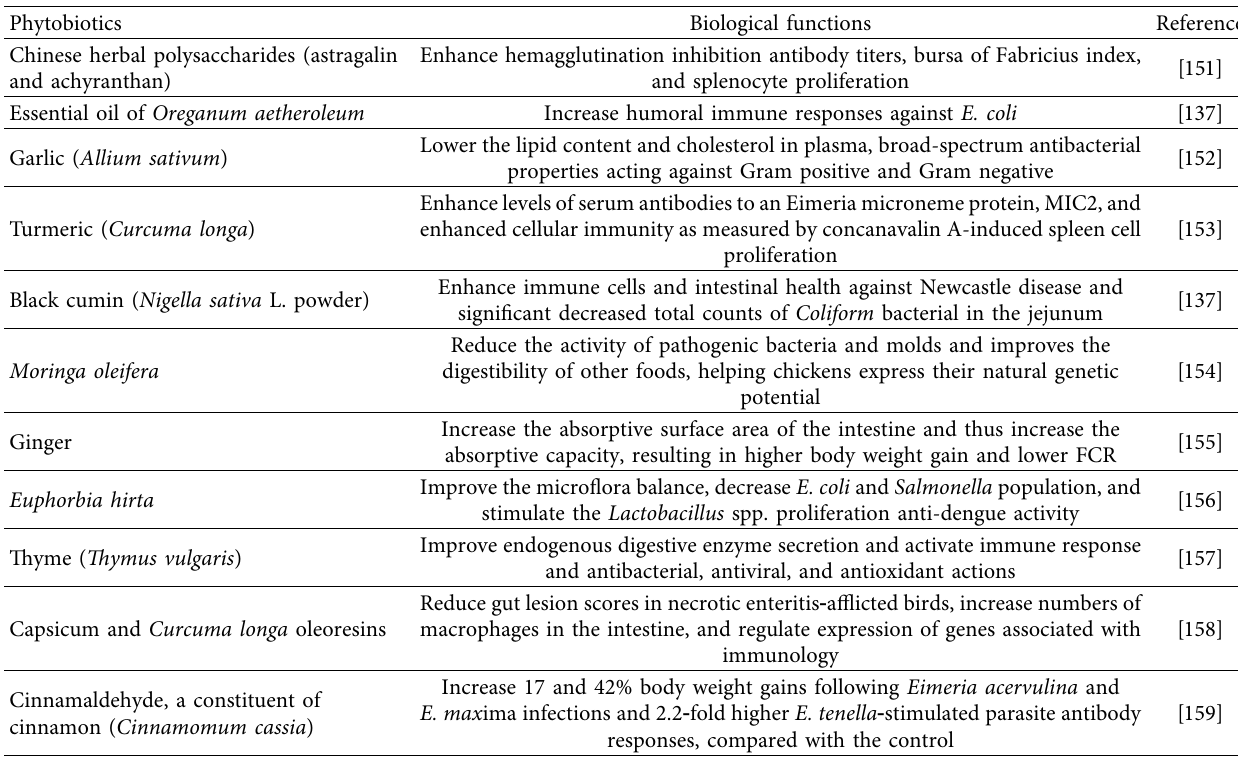
Table 5: Effects of different phytobiotics on intestinal